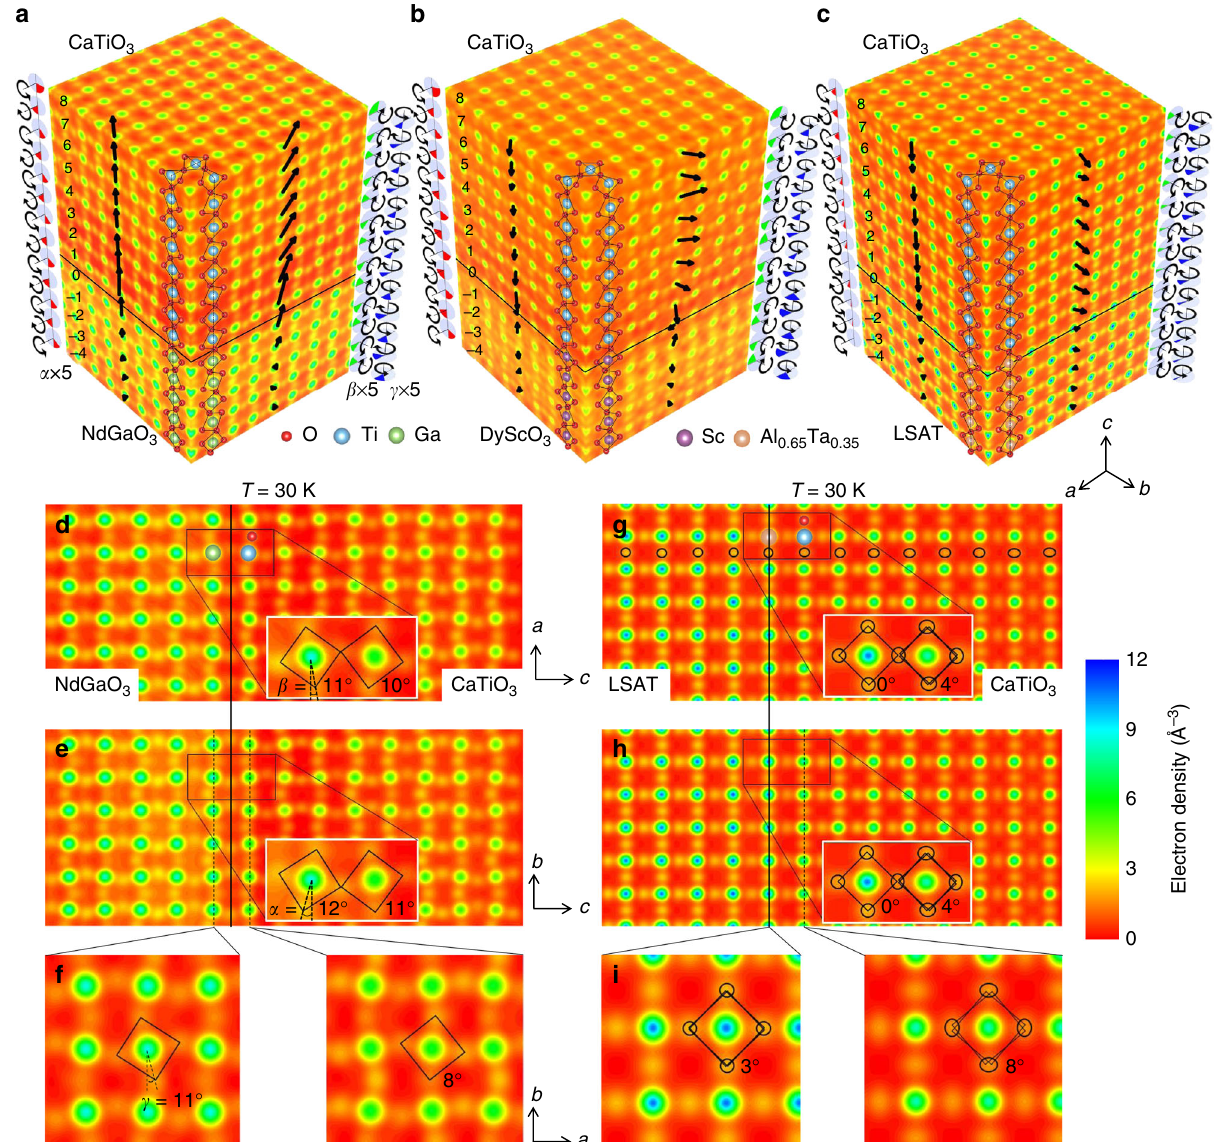
Fig. 2 3D electron densities reconstructed by COBRA at 30 K. Three-dimensional electron densities for a CaTiO 3 /NdGaO 3 , b CaTiO 3 /DyScO 3 , c CaTIO 3 / LSAT at 30 K reconstructed by coherent Bragg rods analysis (COBRA). Polarizations projections on ac and bc planes are displayed on corresponding faces. Oxygen octahedra tilts evolution, α , β , and γ , are magni fi ed by 5 times and displayed by red, green, and blue pie charts along each edge of electron densities. One of the four equivalent CaTiO 3 domains on LSAT are plotted for convenience of comparison. Two-dimensional slices of d ac , e bc , and f ab planes for CaTiO 3 /NdGaO 3 and the corresponding plots g , h , i , for CaTiO 3 /LSAT are shown, respectively. The interconnected oxygen networks are sketched by black squares, which tends to clamp the in-plane tilts ( α and β ) in CaTiO 3 through interface. While, the γ tilt in CaTiO 3 is